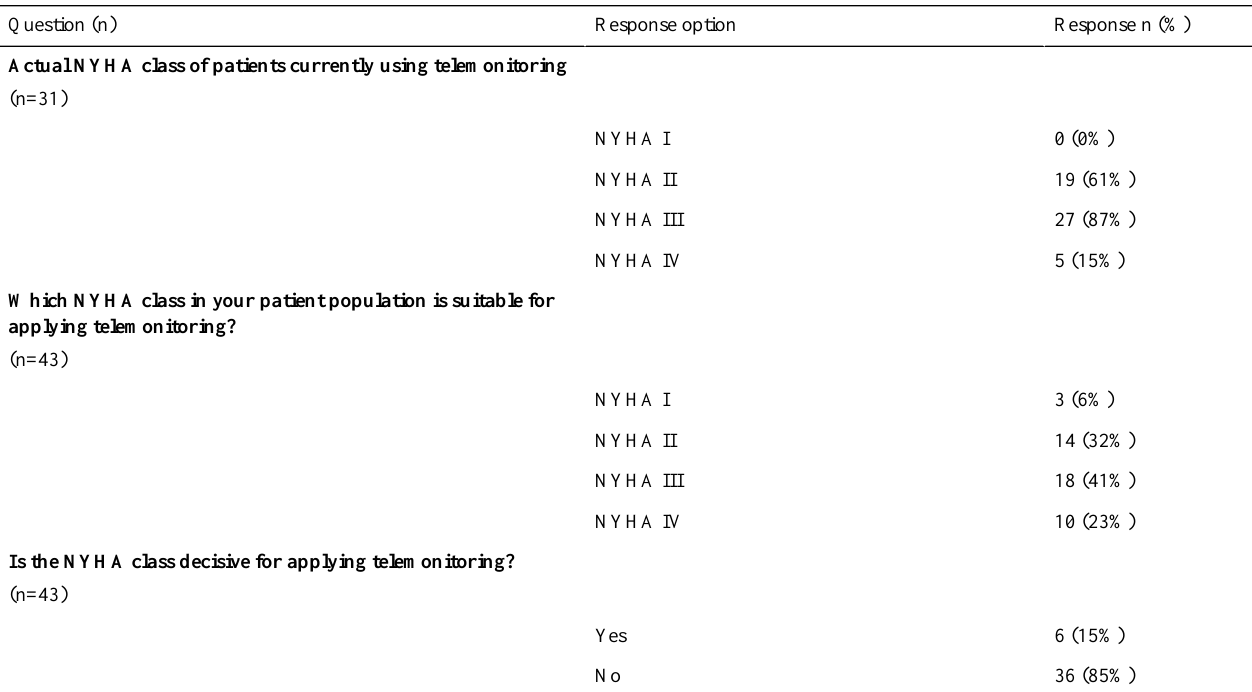
Table 5. NYHA class in telemonitoring (NYHA: New York Heart Association classification for heart failure), more than one answer possible.